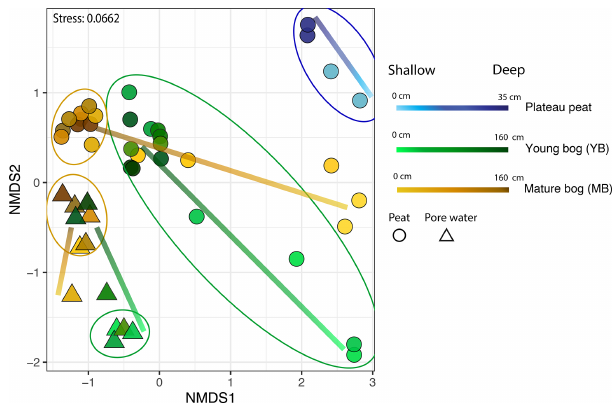
Figure 4. Microbial community distribution according to stage of peat/pore water. NMDS ordinations of amplicon sequencing variant (ASV) data demonstrate significant community dissimilarities ac- cording to thaw stage for both pore water (shown by the triangles) and peat (shown by the circles) samples, encircled by 95% con- fidence intervals. Colour gradient and lines demonstrate the shift in microbial community structure along vertical depth profiles in which lighter shades indicate samples closer to the